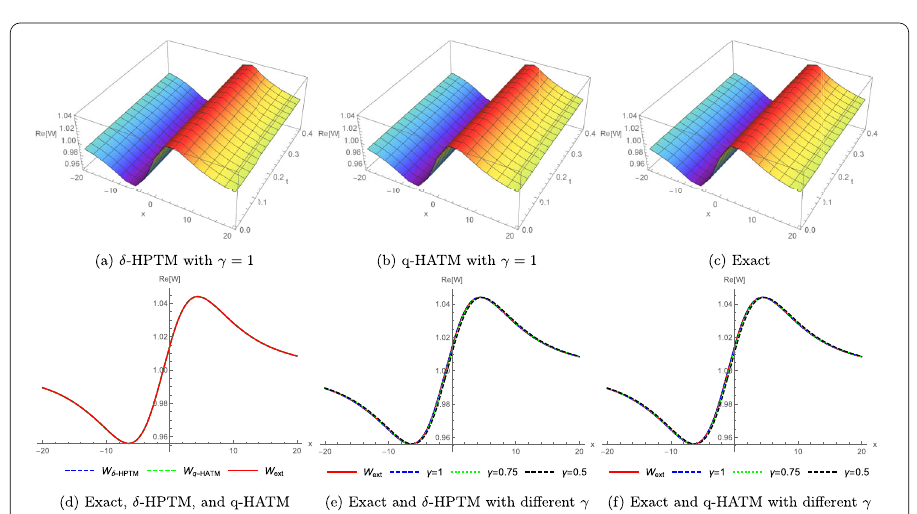
Figure 3 The plots of the real part of δ -HPTM, q-HATM, and exact solution for Example 2